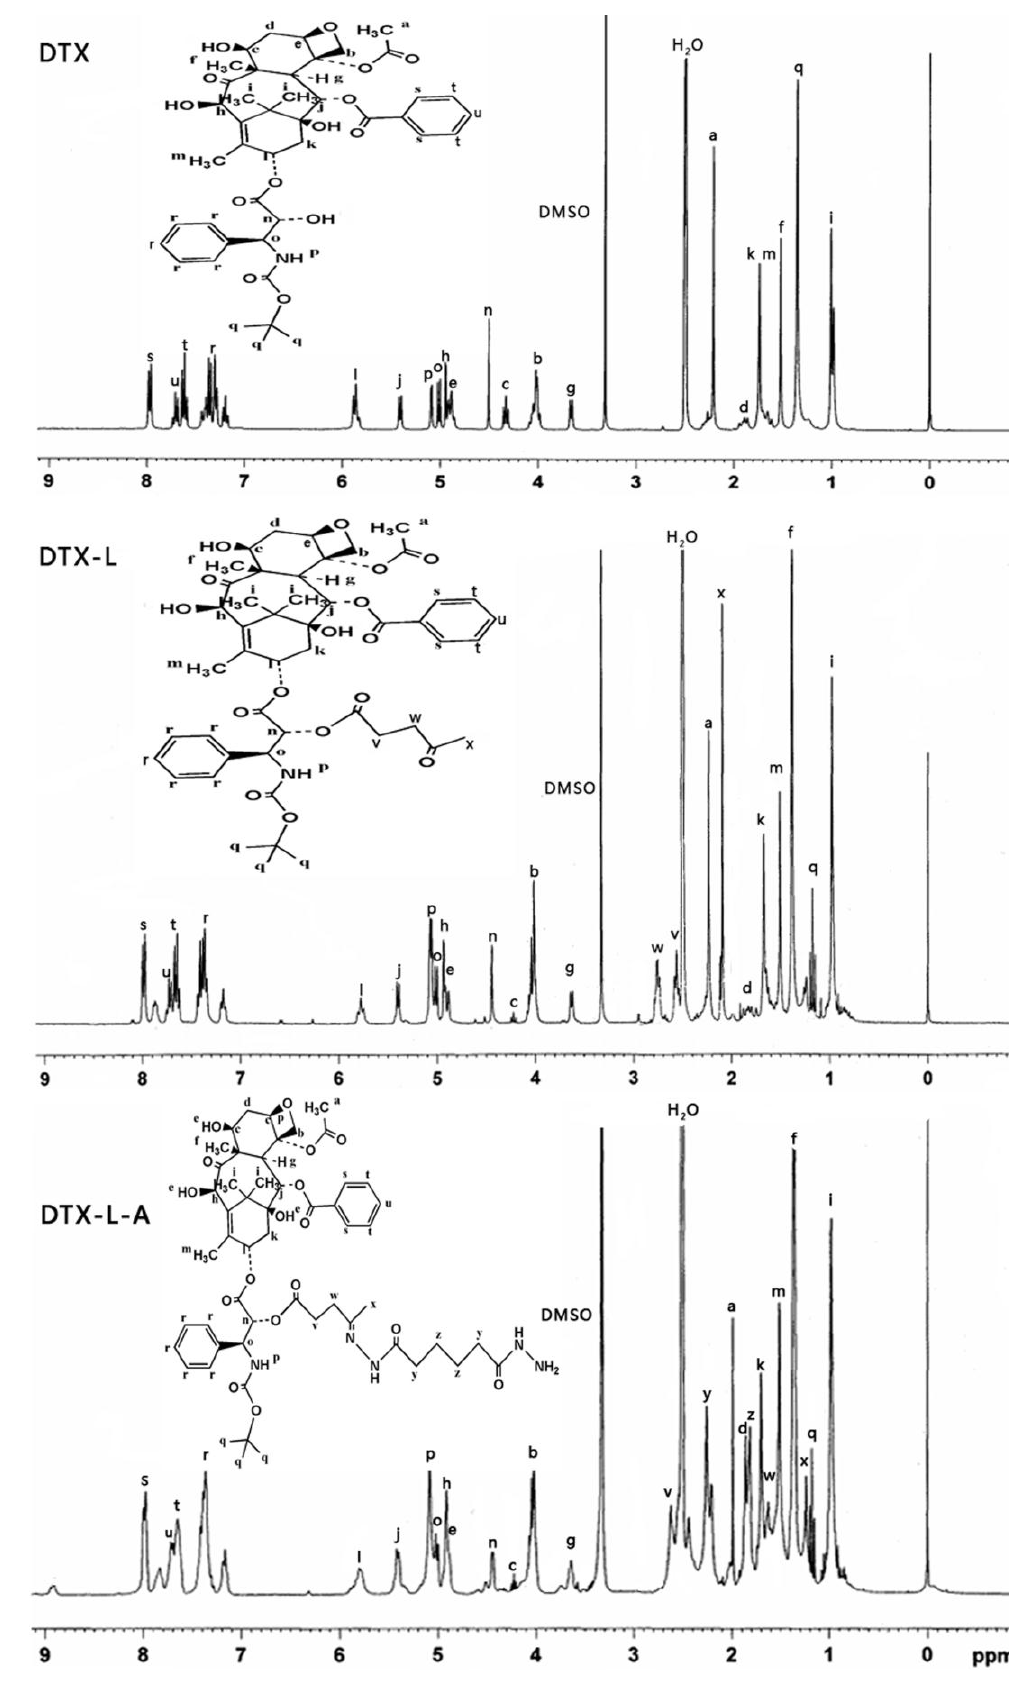
Figure 2. 1 H NMR spectrum of the derivatives of docetaxel (DTX) (DTX, DTX-L, DTX-L-A) in DMSO- d 6